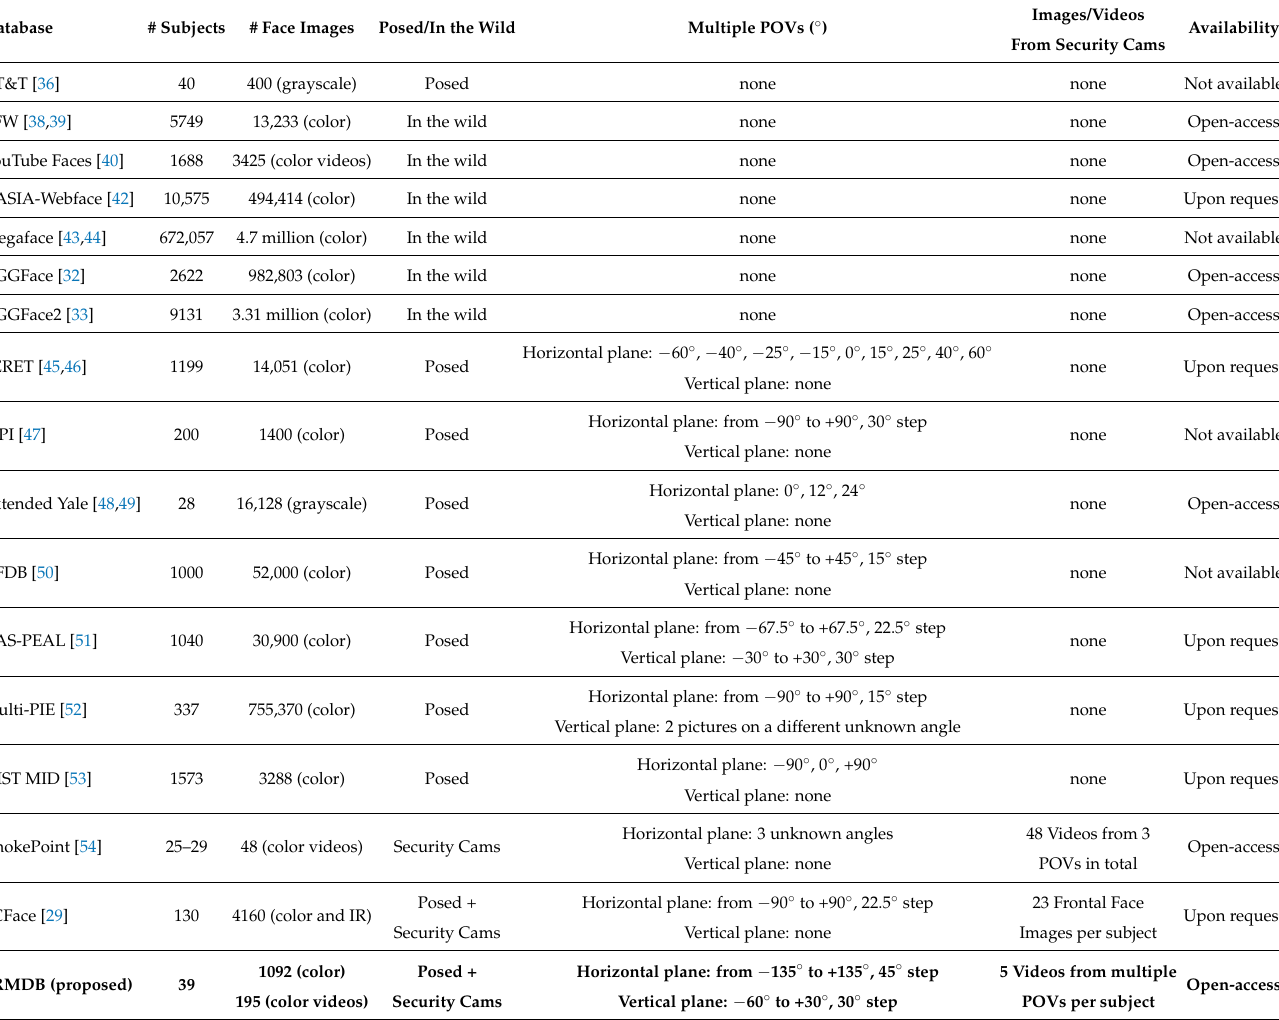
Table 1. A summary of the features of the face databases discussed in Section 2.1 compared to the proposed dataset. The one proposed in this paper is the only dataset including mugshots from multiple POVs, both on the horizontal and the vertical plane, coupled with videos from security cameras taken from multiple points of